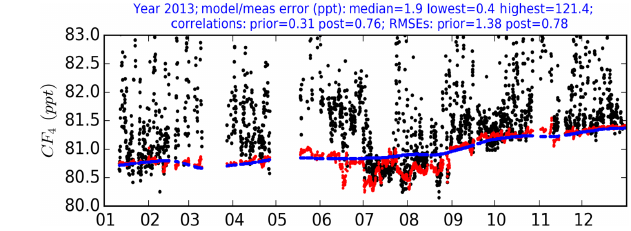
Figure 3. Time series of CF 4 measurements during 2013 – an ex- ample year with the most uninterrupted time series. Prior base- line (blue) is adjusted in the inversion using the baseline condition variables, producing a posterior baseline (red). During the summer months, the proportion of air arriving from the south significantly rises, causing a large shift in the posterior baseline relative to the prior baseline calculated from Mace Head